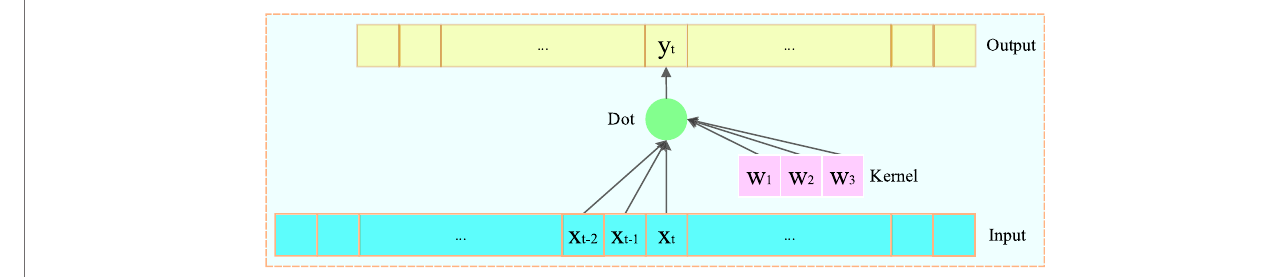
FIGURE 3 | One-dimensional convolution.